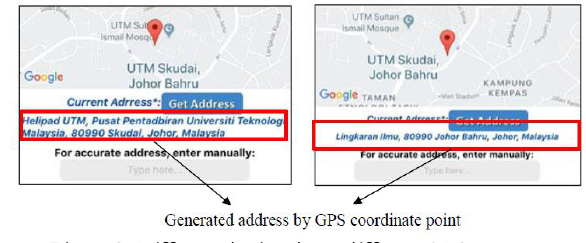
Figure 8. Different devices have different GPS accuracy